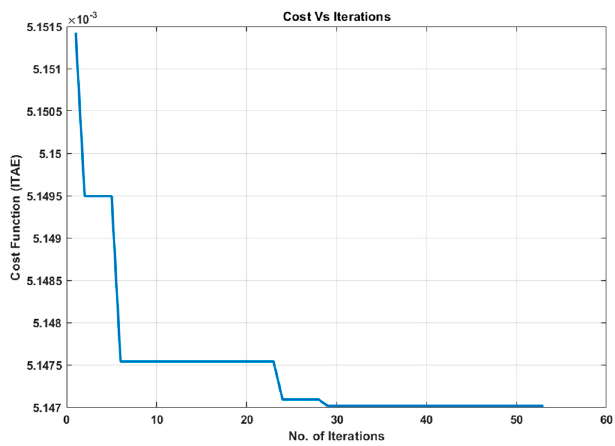
Figure 4. Convergence of PSO algorithm for integral time absolute error (ITAE).